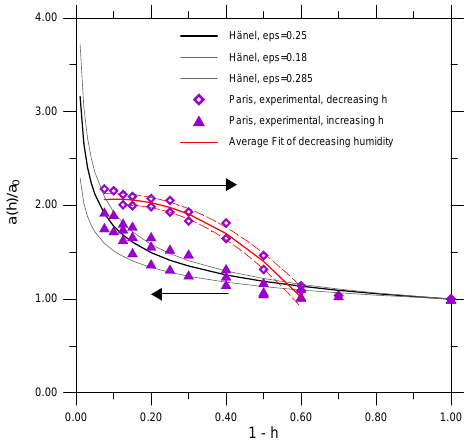
Fig. A10. Comparisons of M ERIS /P MBAER and national air qual- ity measurements PM 10 in Hamburg. The annotation denotes the gauging station and the site location ( BG = background, IND = in- dustry, TRAF = traffic).